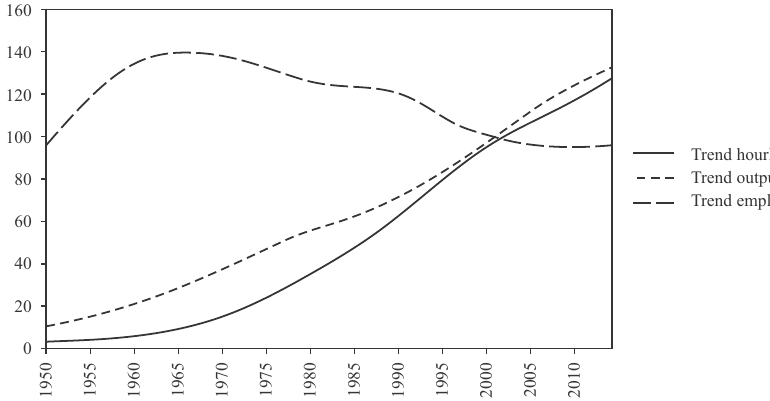
Fig. 2a. The great decoupling in Germany 1950–2014